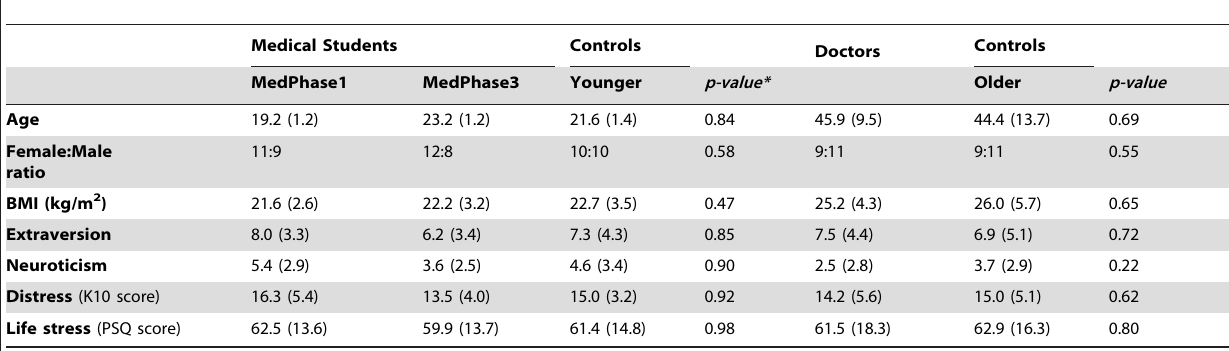
Table 1. Characteristics of the five participant groups including age, sex, BMI, personality aspects and current levels of life stress and